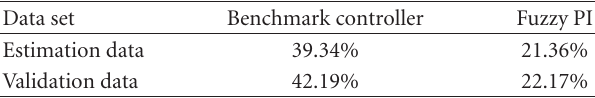
Table 1: Controllers in partial load operation : NSSE% values.